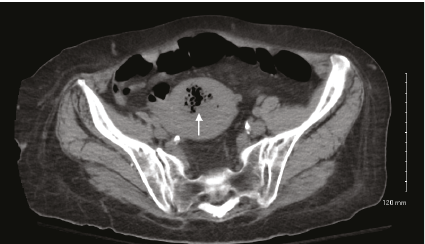
Figure1:AxialCTimageshowingenlargeduteruswithendometrial canal thickening and endometrial canal air (arrow) with surround- ing inflammatory stranding, suggestive of endometritis.